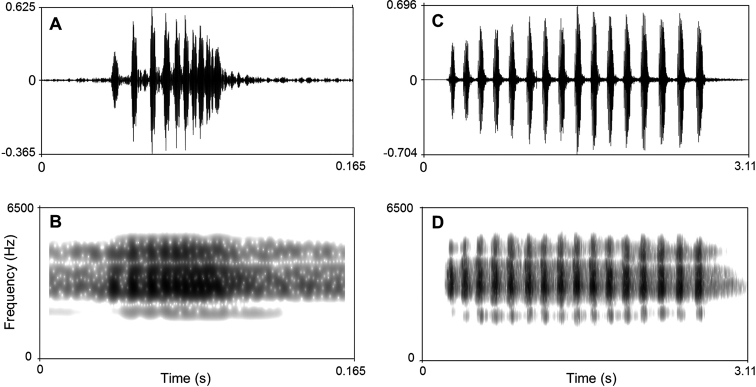
Visualization of advertisement calls of Megophrys
chishuiensis sp. nov. A waveform showing one note B sonogram showing one notes C waveform showing 16 notes of one call D sonogram showing 16 notes of one call.